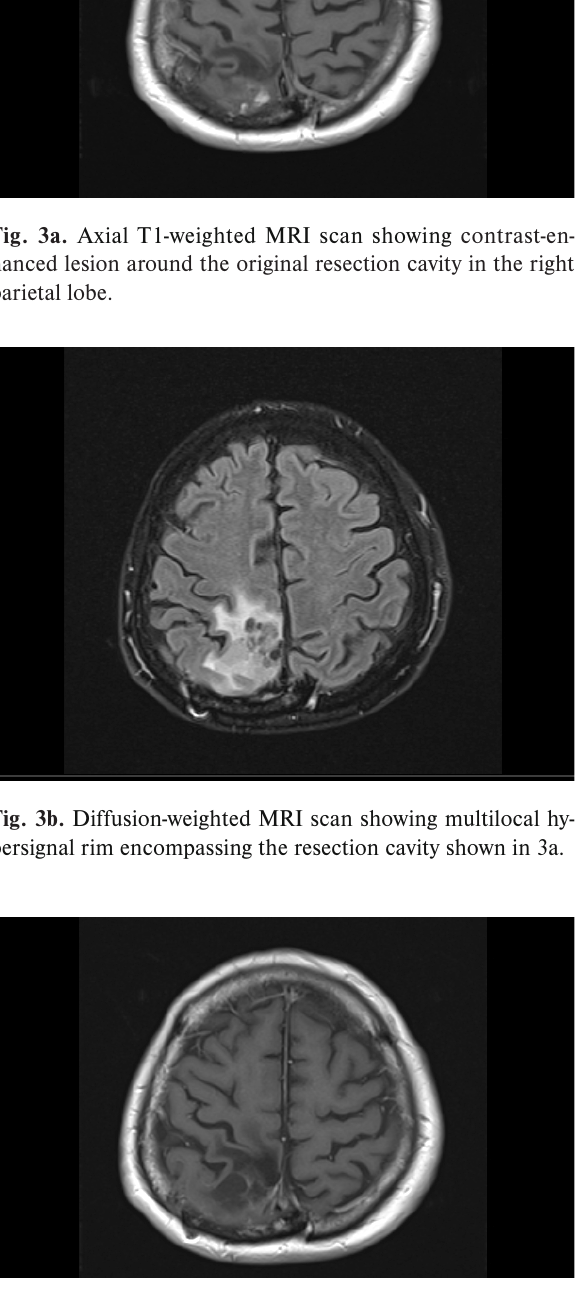
Fig. 3c. Axial T1-weighted MRI scan showing disappearance of the multiloculated contrast-enhanced